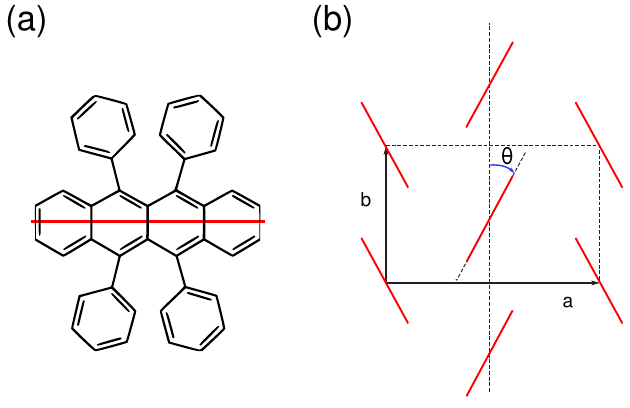
( a ) Molecular structure of rubrene. ( b ) Crystal structure along the (a,b) crystallographic plane. The red lines denote the long axis of the